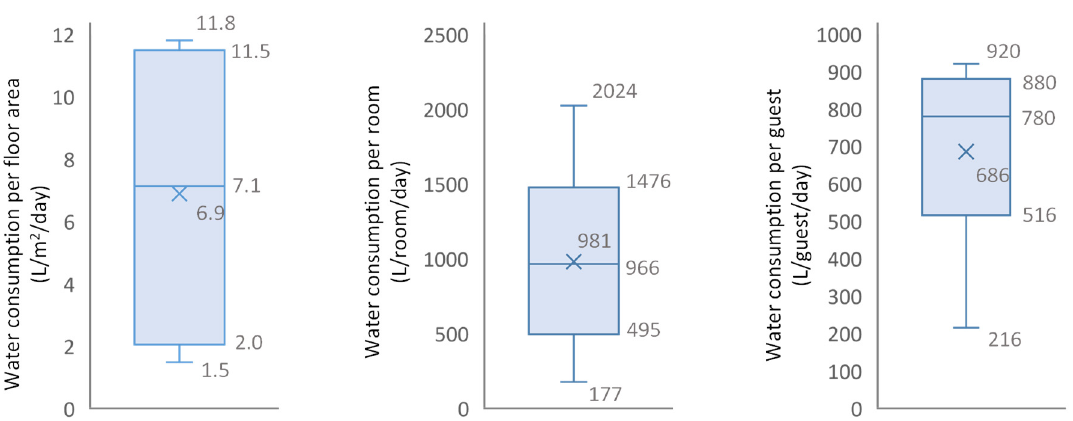
Figure 1. Box-whisker graphs for water consumption per floor area, room, and guest.